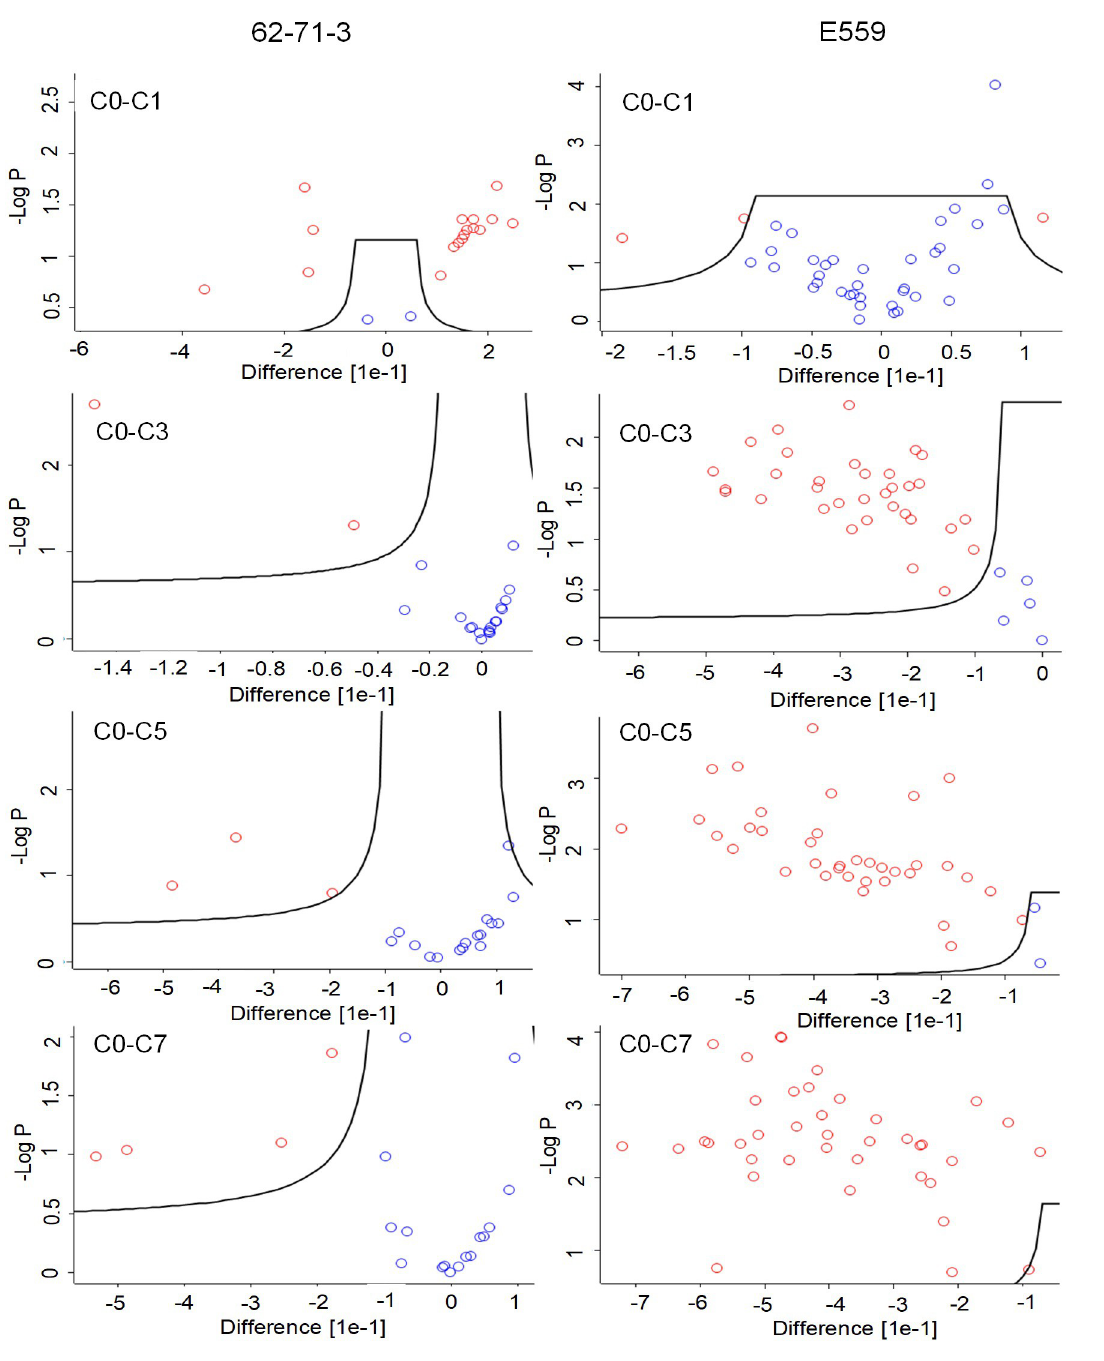
Fig 5. Volcano plots illustrating the effect of freeze-thawing on 62-71-3 (A) and E559 (B) LC peptides. The black solid line delineates peptides that show a significant shift in deuterium incorporation (red dots) versus those that were not affected by F/T (blue dots). Samples were analysed in duplicates. C0 represents non-frozen sample, C1, C3, C5 represent F/T cycle 1, 3, 5 or 7. The circles with a negative (-) difference indicate increased deuterium incorporation compared to the non-frozen sample. The circles with a positive (+) difference indicate decreased deuterium incorporation compared to the non-frozen sample. The FDR was set to 1%, S0 value was set to 0.1 and adjusted p-value cut off was 0.05.